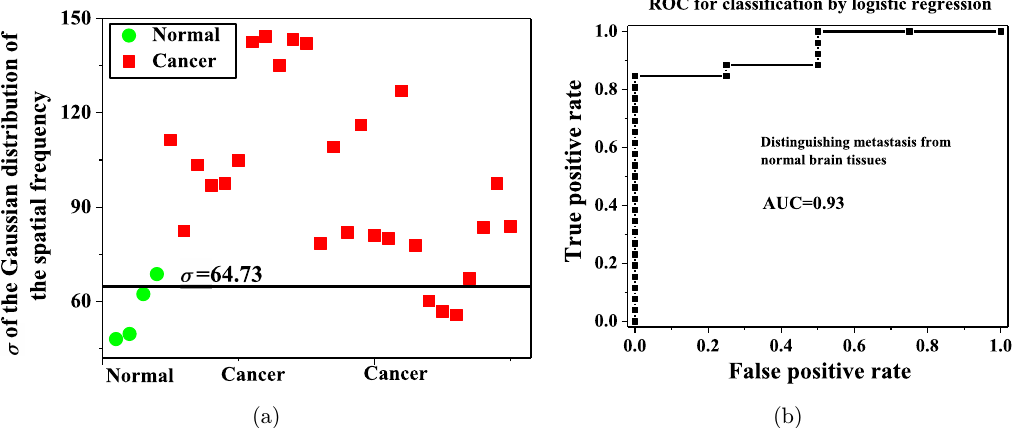
Fig. 3. (a) The (cid:1) of the spatial frequency spectra of four normal brain tissues and 26 cancerous brain tissues. The solid line is calculated using SVM to classify the two tissue types. (b) The ROC curve is used to evaluate the performance of the SVM